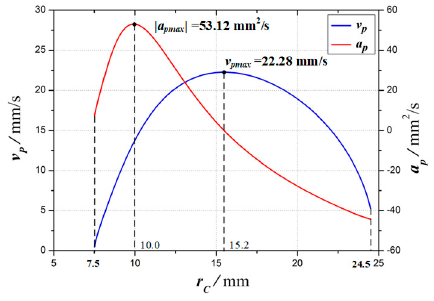
Figure 5. Theoretical velocity and acceleration of point P .